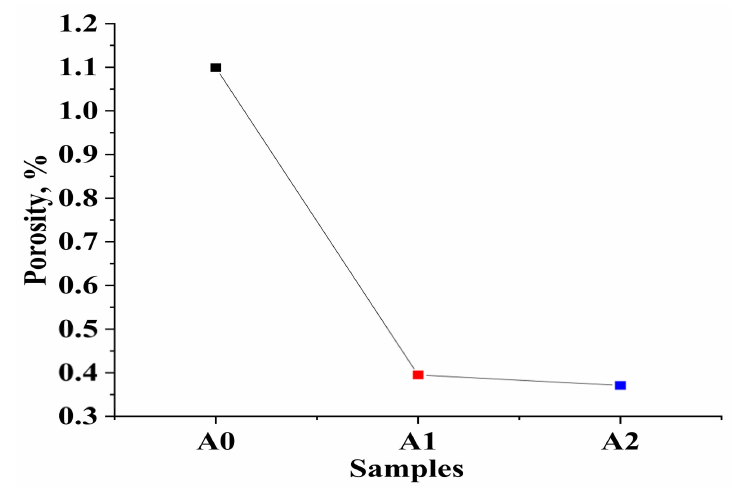
Figure 4. Porosity.